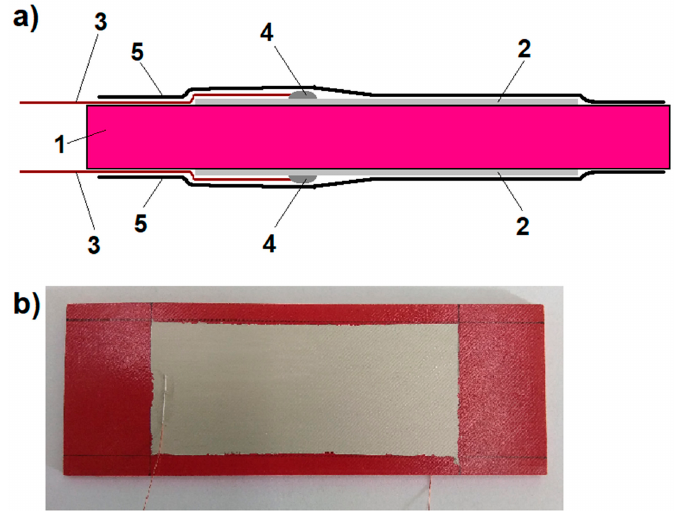
Figure 3. The prepared sample of the piezoelectric composite applied to the PLA grid core: ( a ) a front-view cross-section schema showing the arrangement of the individual elements on the sample surface; 1—the piezoelectric composite on the grid core, 2—silver electrode, 3—copper wire outputting a signal, 4—electrode-wire connection point, and 5—external PVC securing tape, ( b ) a photo of atop of the sample before securing it with PVC tape.